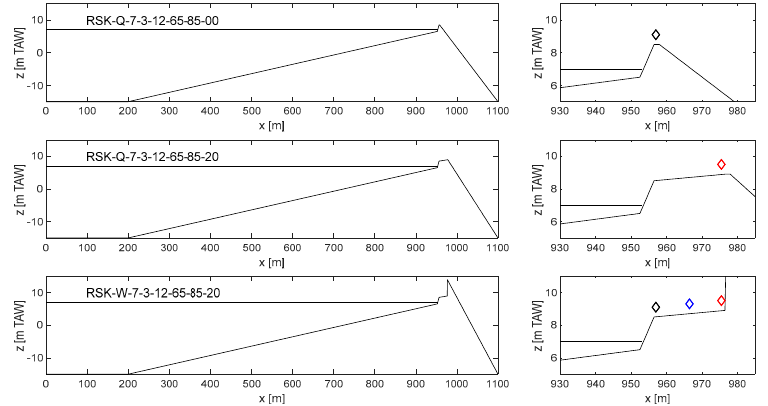
Figure 1. Bathymetries (type Q and W) and measurement points (black points: beginning, blue point: middle, red points: end of the promenade).